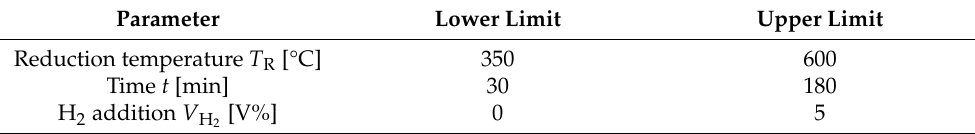
Table 2. Parameter limits of the thermal reduction 2-factorial screening